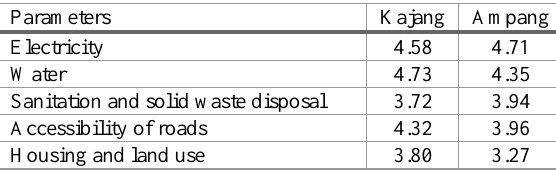
Table 3: Assessment of Physical Component . Source: Research